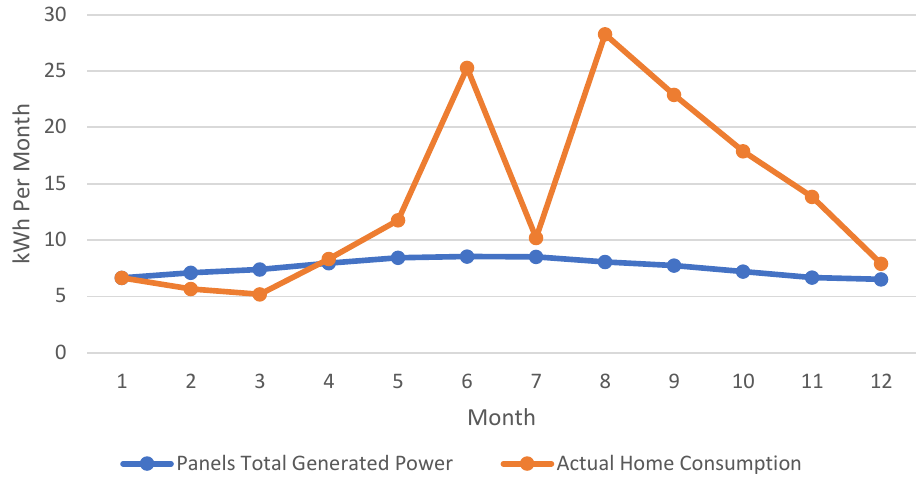
Figure 4. LPE vs. LPN (20% vs. 2 panels) .